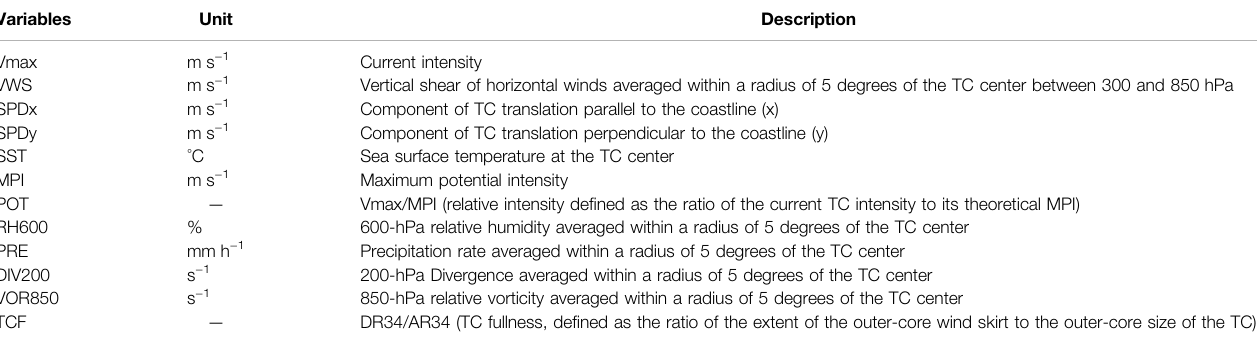
TABLE 2 | List of the factors (their unit and description) analyzed in this study.